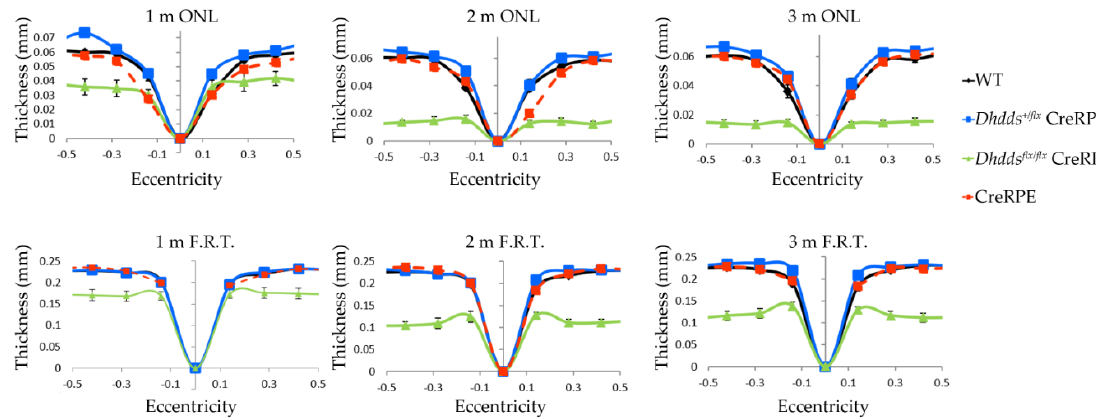
Figure 4. Quantitative morphometric analysis of WT, CreRPE, Dhdds +/flx CreRPE, and Dhdds flx/flx CreRPE mice SD-OCT data. Average OCT measurements at each eccentricity revealed no significant differences when comparing WT, CreRPE and Dhdds +/flx CreRPE mice for both outer nuclear layer (ONL) and F.R.T. thickness measurements (n = 4 for all genotypes, except for WT at one month (1 m; n = 8) and two months (2 m; n = 5). However, significant changes were observed when comparing WT and Dhdds flx/flx CreRPE mice at any age with respect to both ONL and F.R.T. values.